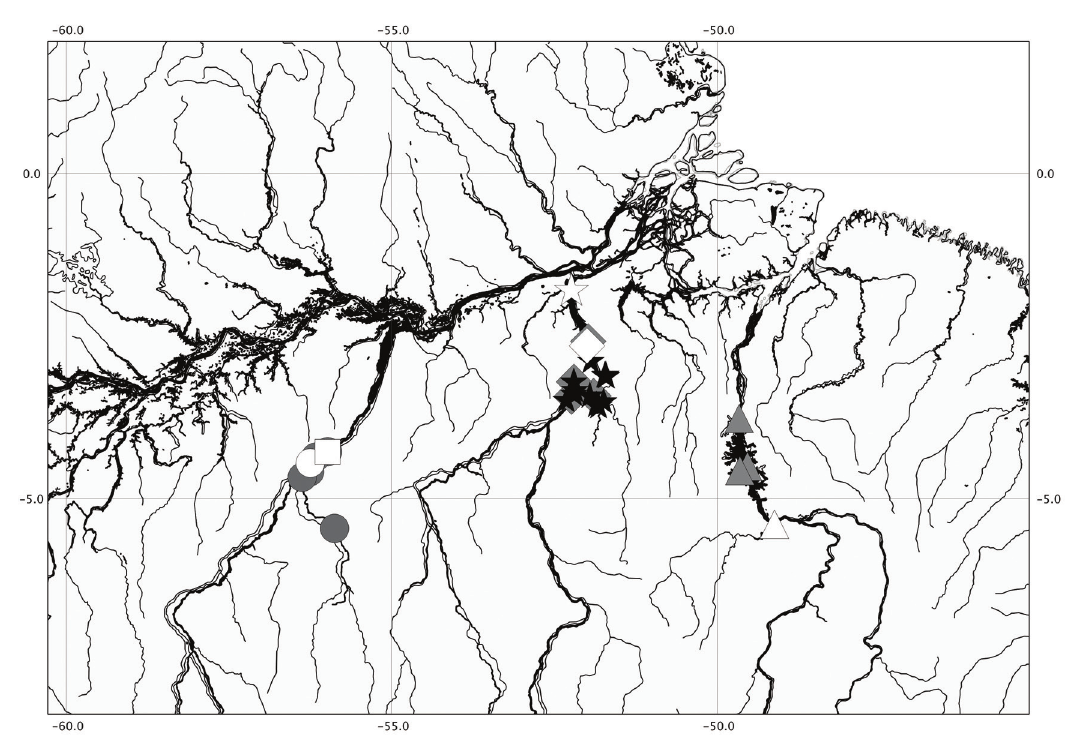
Fig. 5. Distribution map for the species of Spectracanthicus . Circles, S. murinus ; stars, S. punctatissimus ; squares, S. immaculatus ; triangle, S. tocantinensis and diamon, S. zuanoni . White symbols refers to type